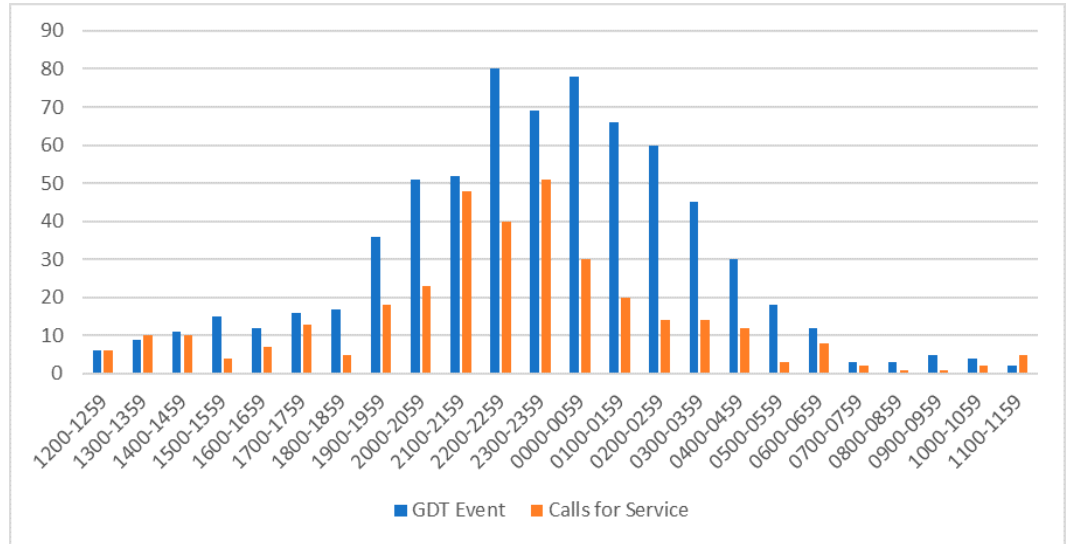
Figure 3. GDT events and calls for service by hour of the day, starting at noon.